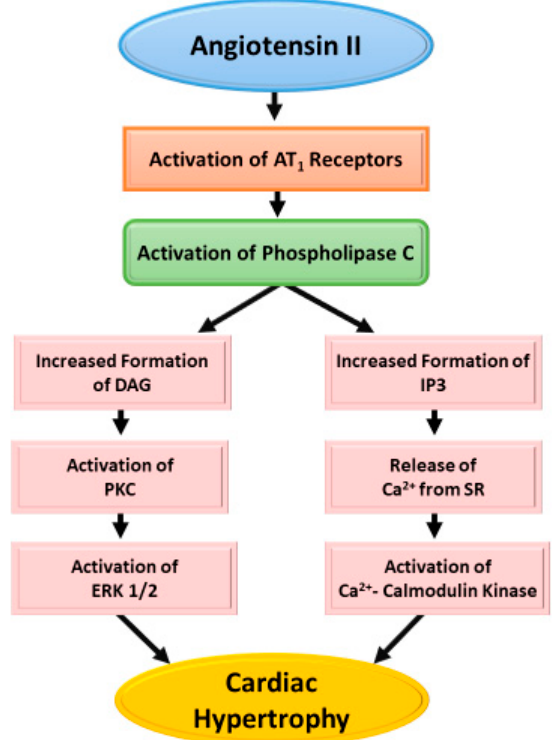
Figure 2. A schematic representation for the AT 1 receptors and phospholipase C mediated signal transduction pathways for the development of Angiotensin II- induced cardiac hypertrophy. The activation of AT 1 R has been shown to promote Ca 2+ —entry through sarcolemmal Ca 2+ channels and increase the intercellular concentration Ca 2+ , which may also contribute to activating Ca 2+ calmodulin kinase for the occurrence of cardiac